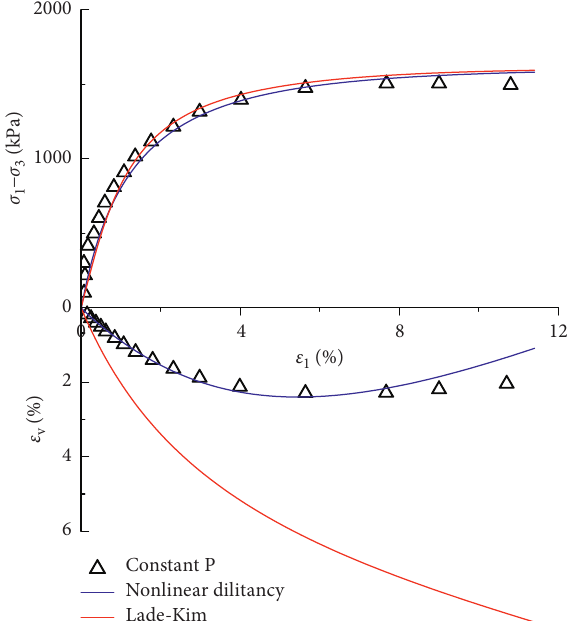
Figure 16: Model prediction results for CP experiments.